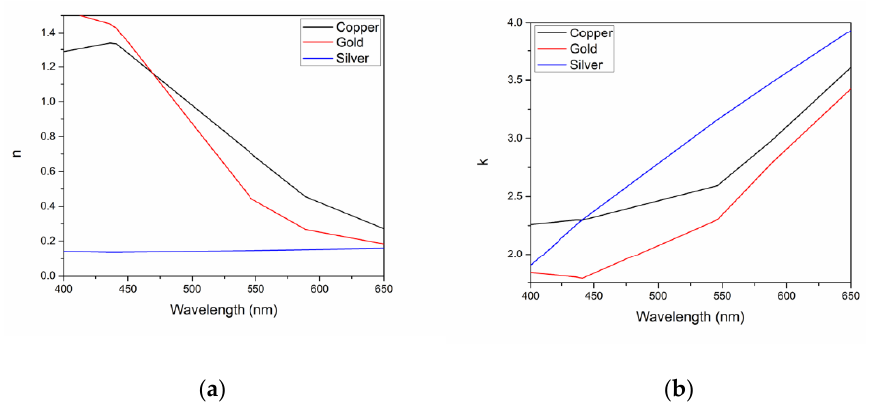
Figure 3. ( a ) Real part and ( b ) imaginary part refractive index for copper, gold, and silver from 400–650 nm wavelength.